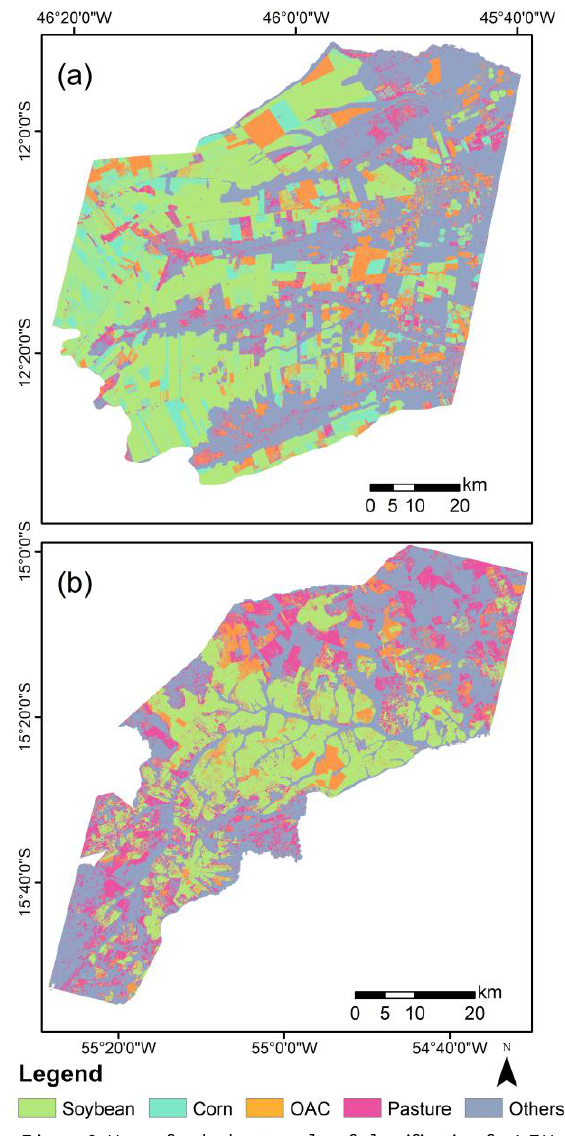
Figure 6. Maps for the best results of classification for LEM and Campo Verde test site: (a) LEM: 03-15-2018 (scenario 12 BP); (b) Campo Verde: 03-09-2016 (scenario 10